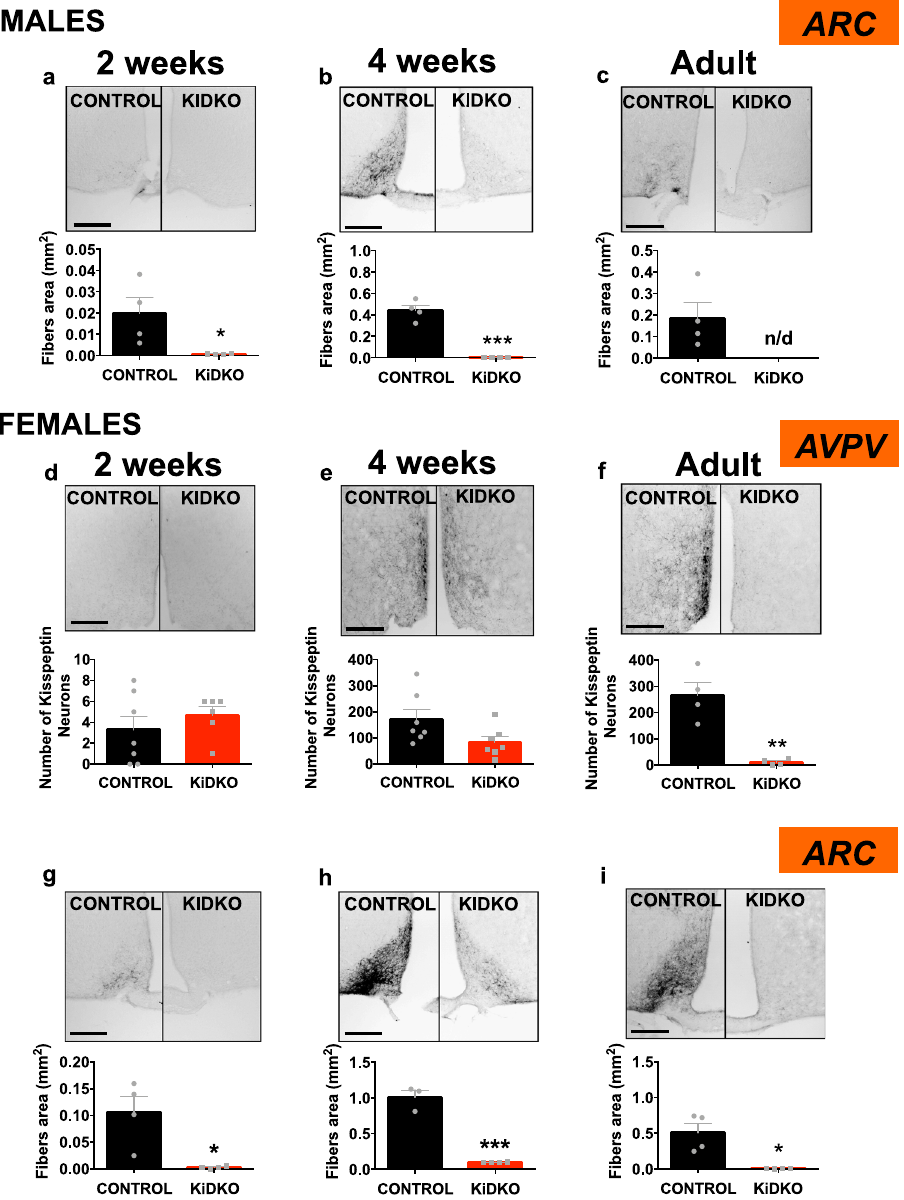
Fig. 4 | Hypothalamic kisspeptin-immunoreactivity in KiDKO mice along postnatal maturation. Detection of kisspeptin content in situ was conducted using immunohistochemistry. Due to the features of immunoreactivity (IR) of kis- speptininthemousehypothalamus,thisprocedureallowedthedetectionof fi bers intheARC,whilepermittingthecountingofnumbersofkisspeptin-IRcellsinAVPV. Representative images and quantitative data on kisspeptin-IR fi bers (area) or cells in the ARC of males ( a – c ) and the AVPV ( d – f ) and ARC ( g – i ) of females of control and KiDKO genotypes are presented. Data were collected at three postnatal ages: 2weeks(correspondingtomini-puberty),4weeks(correspondingtoearlypubertal